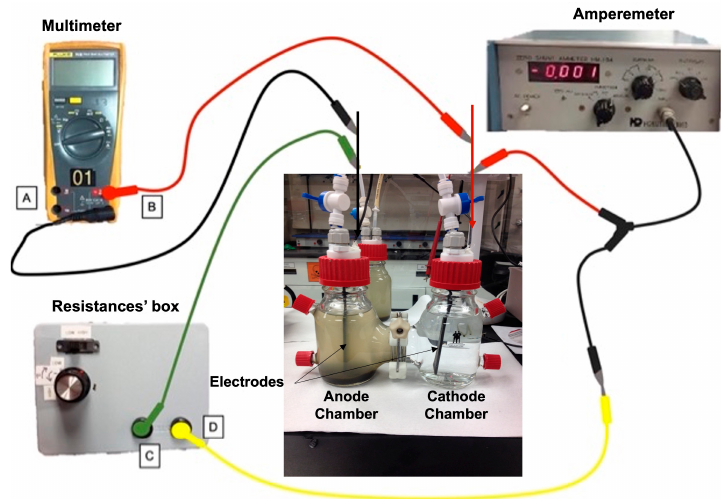
Figure 1. Experimental device: Lab-scale MFC. A: negative terminal of the multimeter; B: positive terminal of the multimeter; C: a terminal (-) that connects the resistance ´ s box to the MFC anode; D: a terminal (-) that connects the amperemeter to the resistance ´ s box; red cables: positive connectors from the multimeter and amperemeter to the MFC cathode; black cable: negative connector from the multimeter to the MFC node; yellow cable: negative connector from the amperemeter to the resistance ´ s box; green cable: negative connector from the resistance ´ s box to the MFC